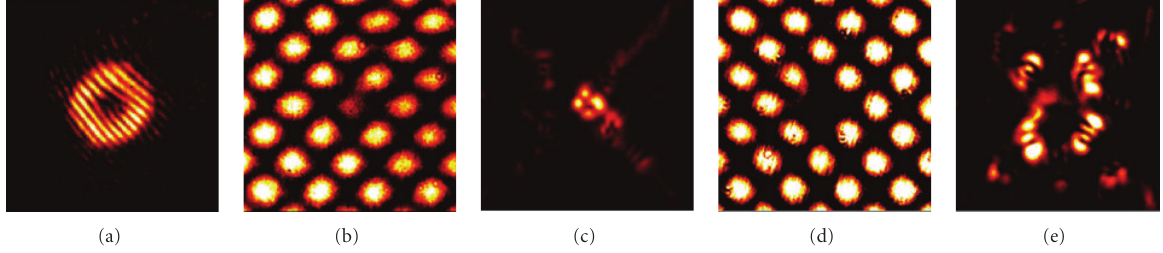
Figure 9: Experimental results of bandgap guidance f a DCV beam in a tunable negative defect. (a) interference pattern of input vortex with an inclined plane wave (zoomed in), (b) lattice beam with a nonzero-intensity defect, (c) linear output of the doubly charged vortex beam exiting the defect channel in the lattice (b), (d) lattice beam with a zero-intensity defect, and (e) linear output of the DCV through the defect in lattice